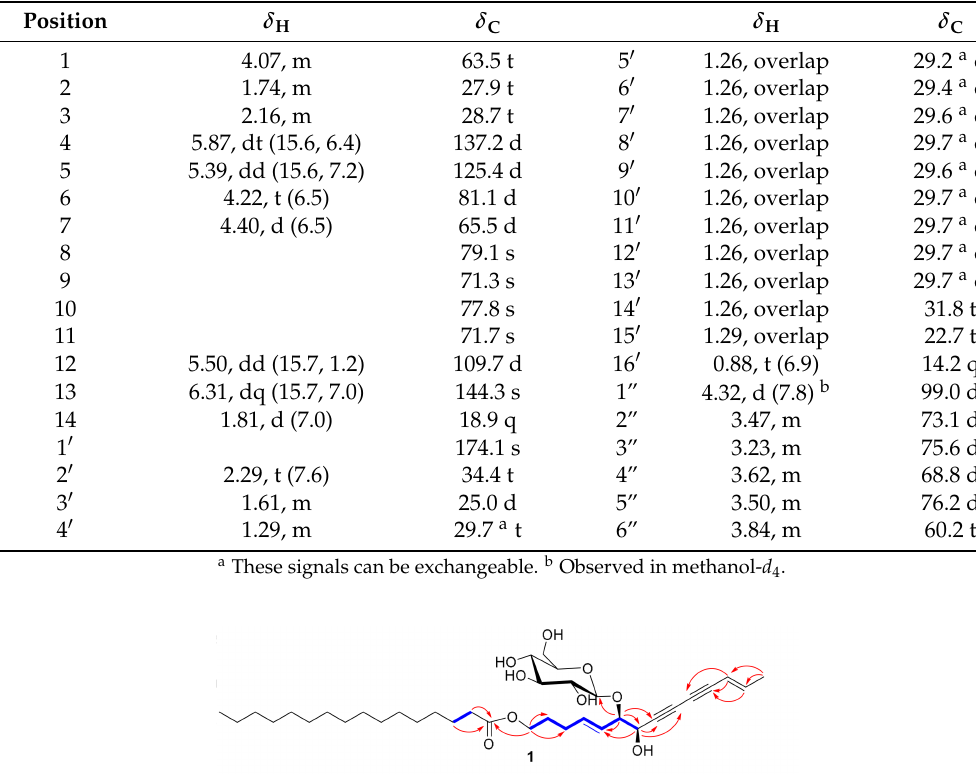
Table 1. 1 H- (600 MHz) and 13 C-NMR (150 MHz) data of 1 in CDCl 3 ( δ in ppm, J in Hz).